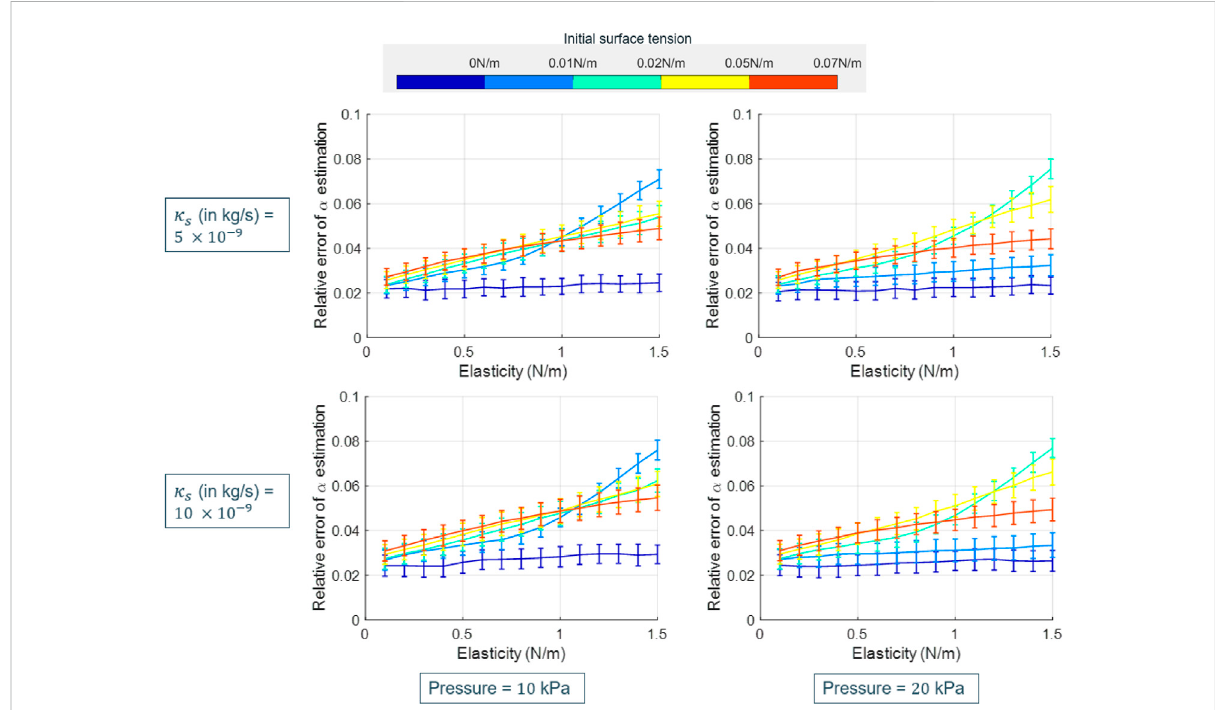
FIGURE 7 Plots for the relative error of the attenuation estimates as obtained by applying the proposed approach on the simulated SonoVue data, as a function of the shell elasticity. In each plot, the relative error curves for different initial surface tension values are displayed (values shown in the colorbar). The shown plots are for varying shell viscosity (row-wise) and acoustic pressure (column-wise), and represent the mean error values, computed over the estimator ’ s results on 10 different datasets, along with the associated standard deviation in the form of error